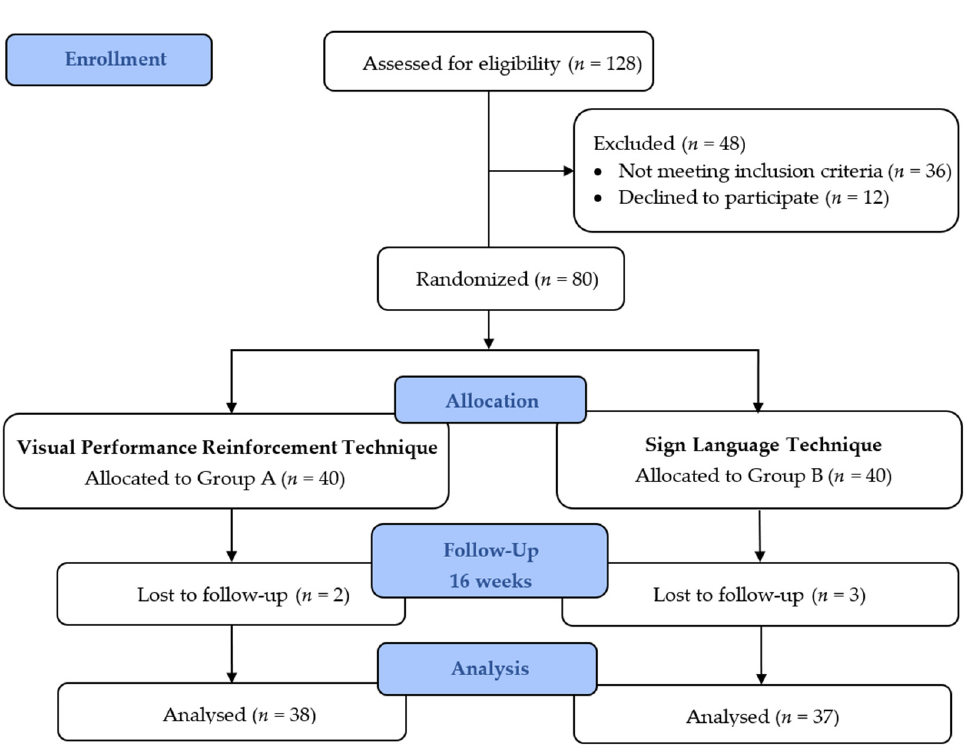
Figure 1. Consolidated Standards of Reporting Trials (CONSORT)